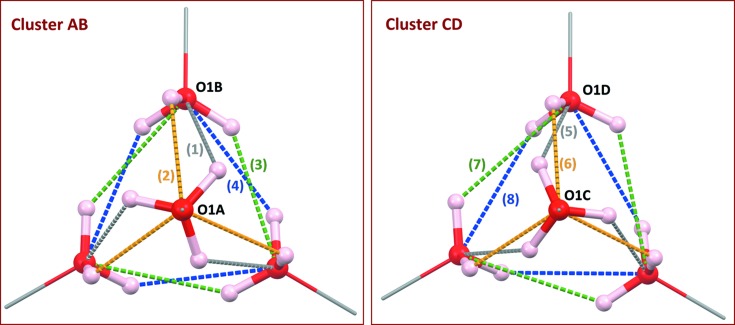
Complete set of hydrogen bonds, represented as dashed lines, in the tetra­mer formed by mol­ecules A and B (left), and in the tetra­mer formed by mol­ecules C and D (right). Figures are oriented down the crystallographic threefold axis. Labels (1)⋯(8) on hydrogen bonds indicate the entry in Table 2 ▸. Each cluster has four independent bonds, affording 12 bonds for the tetra­mer, consistent with the C
3 point symmetry of the tetra­mer. These figures can be compared to the model published in 1999 (see Fig. 4 ▸ in Serrano-González et al., 1999 ▸).